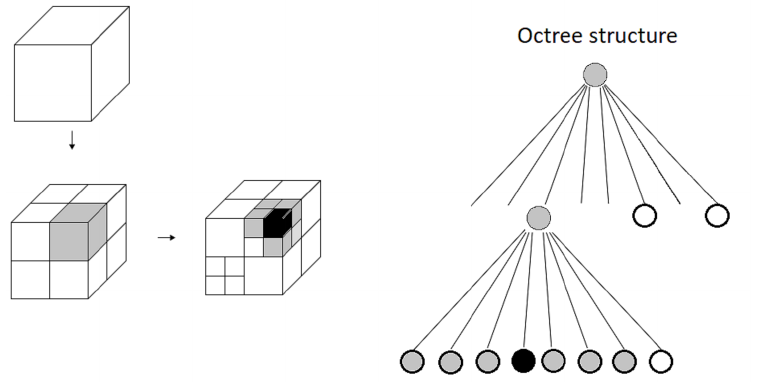
Figure 7. Example of an octree storing free (shaded white) and occupied (black) cells. The volumetric model ( left ) and the corresponding tree representation ( right ). Reproduced from